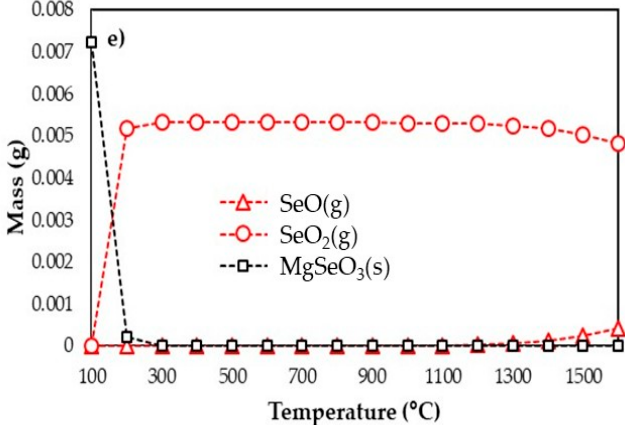
Figure 6. Equilibrium composition of TEs-Coal fly ash components interaction: ( a ) arsenic; ( b ) chromium; ( c ) fluorine; ( d ) boron, and ( e ) selenium.